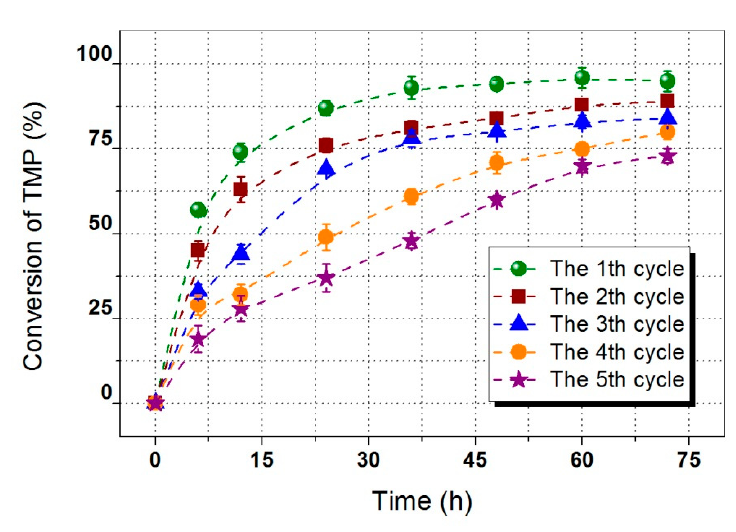
Figure 7. Reusability of biocatalyst during the synthesis of TMP ‐ tri ‐ LA ester.